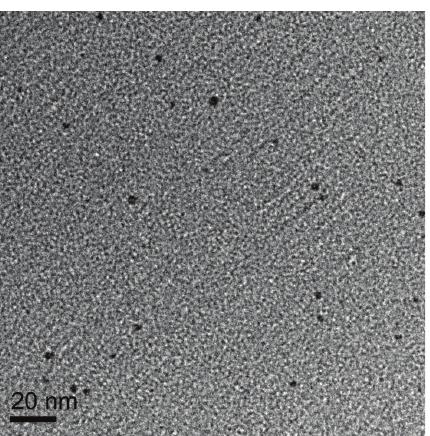
Figure 3: TEM images of Au-1 catalyst after recycling for 5